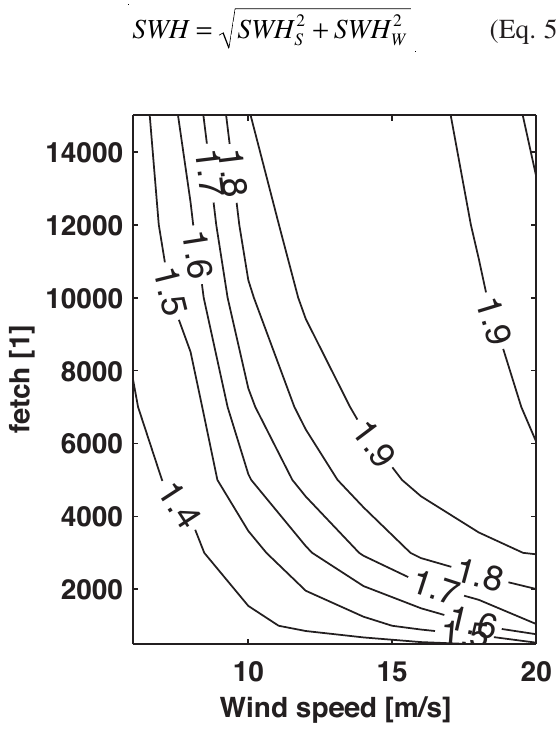
F IG . 1. – α variations with